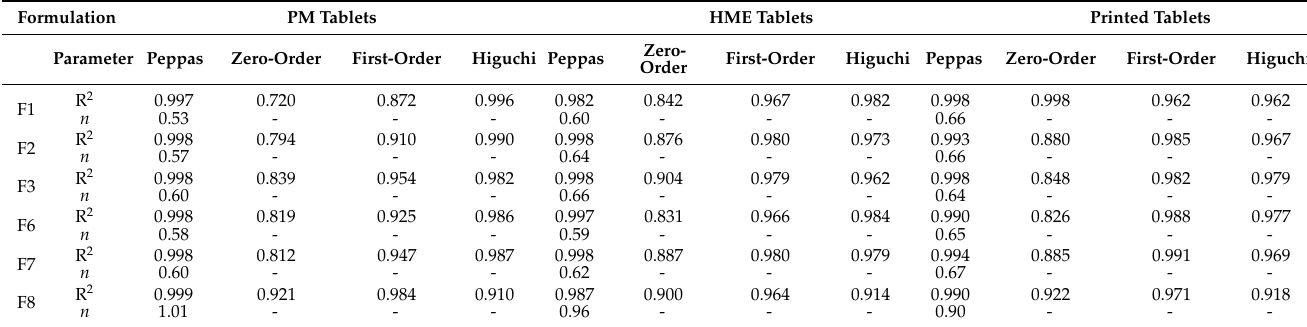
Table 11. Parameters of release kinetics for several